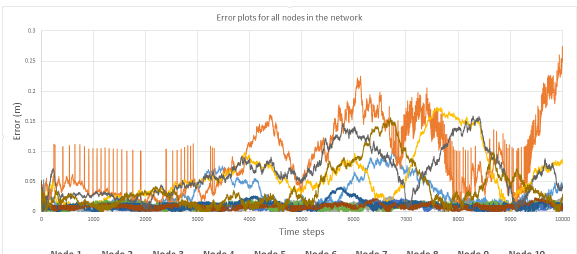
Figure 6: Error plots for all the nodes in the network assuming fully connected work and when GNSS is available only to 5 of the nodes.